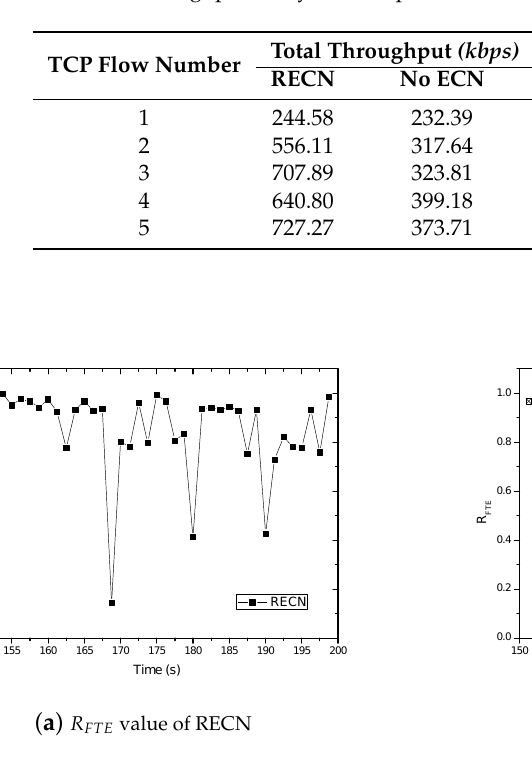
Table 3. TCP throughput analysis. Compare the two situation: RECN and No ECN.